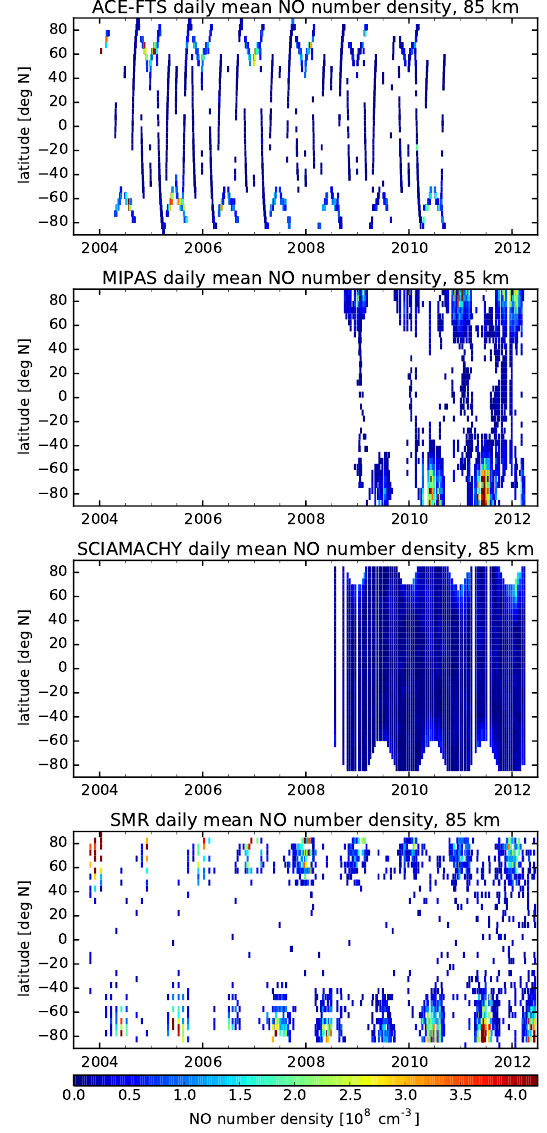
Figure A1. NO zonal mean time series at 75km from ACE-FTS, MIPAS, SCIAMACHY, and SMR (from top to bottom).